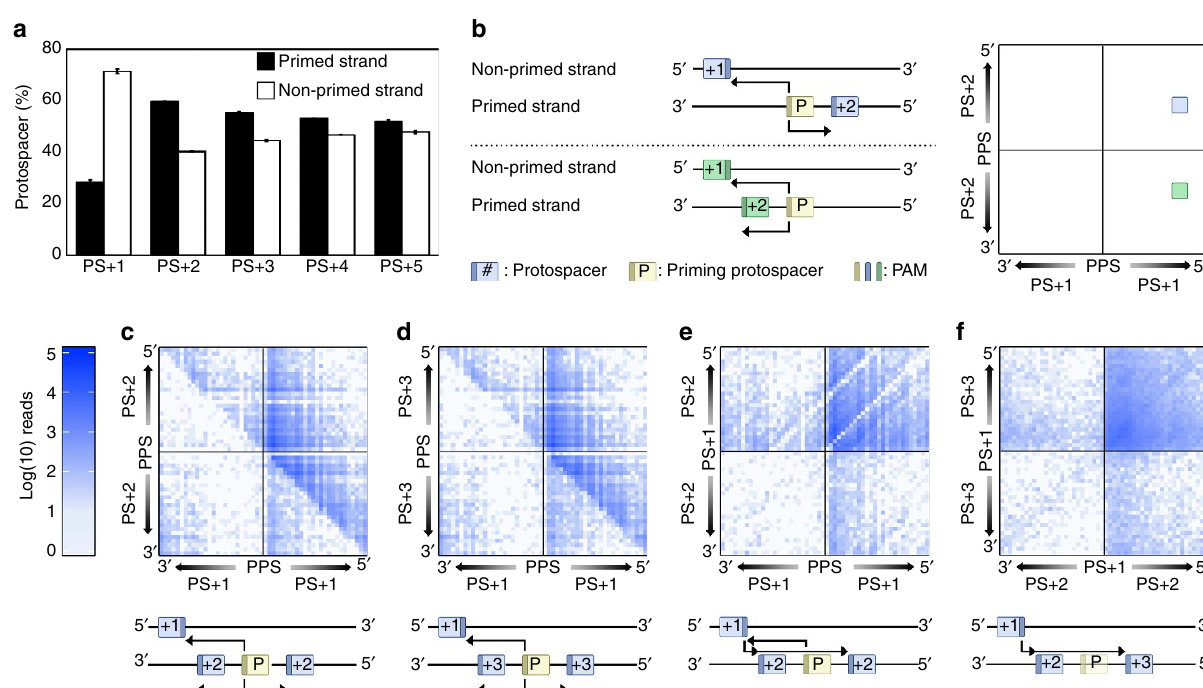
Figure 6 | Strand and directionality bias of sequentially acquired spacers. ( a ) Proportion of protospacers targeted by spacers in CRISPR1 mapping to the primed (black) or non-primed strand (white). The protospacer targeted by the first acquired spacer (that is, the most leader-distal, new spacer) is designated PS þ 1, with later targeted protospacers designated PS þ 2, PS þ 3 and so on. Error bars represent the s.e. of the mean. ( b ) Schematic for the interpretation of the heatmaps presented in ( c – f ). The (shortest) distance in nt from one protospacer to another was calculated. Protospacers with a 5 0 location with respect to a previous one were given a positive distance value, while 3 0 located protospacers obtained a negative distance value. The strand used for positive versus negative distance assignment is the strand on which the second protospacer of the pair is mapped. For example, PPS to PS þ 1 would be scored on the strand that PS þ 1 was located (that is, the known 3 0 –5 0 directionality of Cas3 on the displaced strand). The distances of two such ‘travels’ (for example, PPS to PS þ 1 and PPS to PS þ 2) are plotted in the heatmap. Colour-intensity depicts how many reads were associated with these particular ‘travel distances’. Heatmaps were created for the ‘travel distances’ from subsequent protospacers on the non-primed (PS þ 1), primed (PS þ 2 or PS þ 3) strands. ( c ) PPS to PS þ 1 and PPS to PS þ 2, ( d ) PPS to PS þ 1 and PPS to PS þ 3, ( e ) PPS to PS þ 1 and PS þ 1 to PS þ 2, and ( f ) PS þ 1 to PS þ 2 and PS þ 1 to PS þ 3. The pPriming( (cid:2) ) dataset was used to generate the data displayed in all